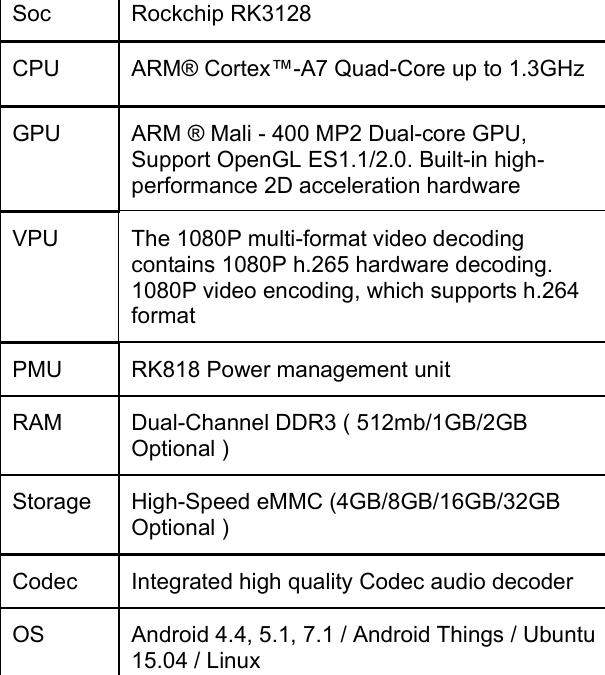
Table 1. Characteristics of the RK3128